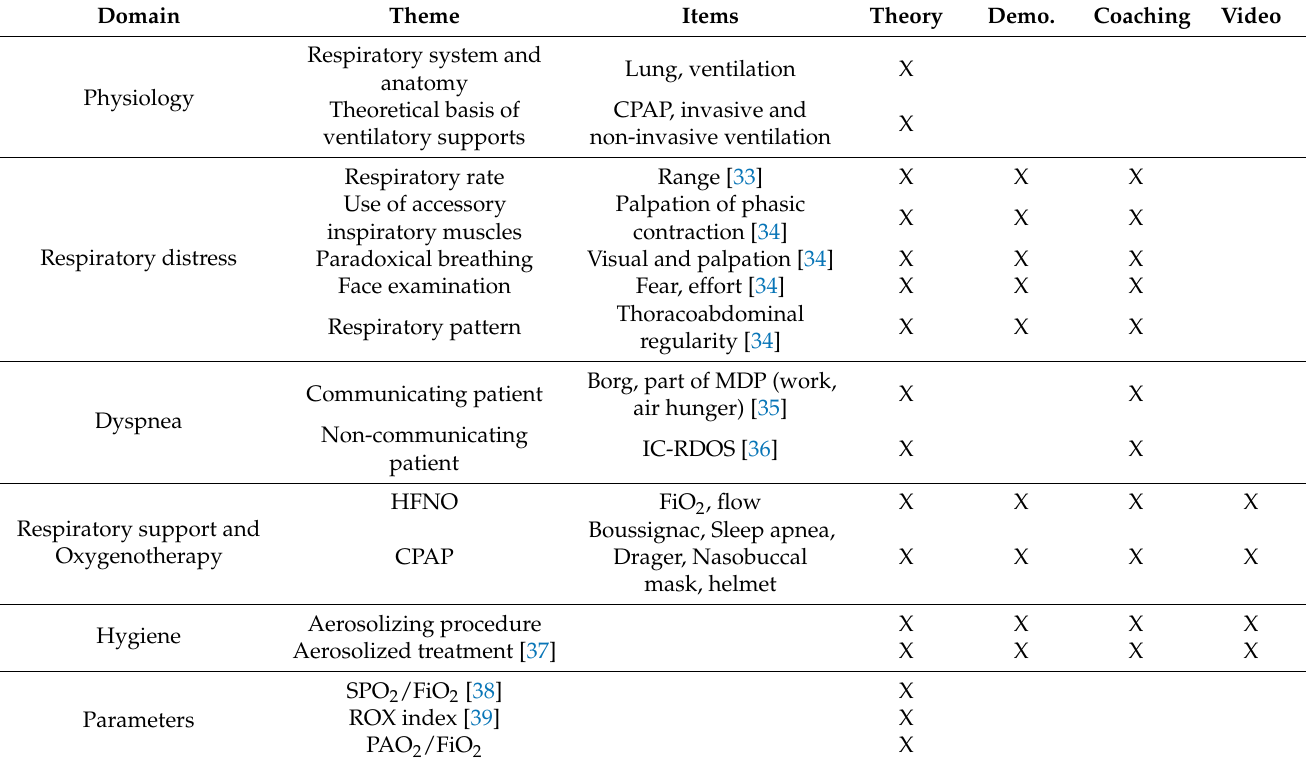
Table 3. Educational setup used when developing the